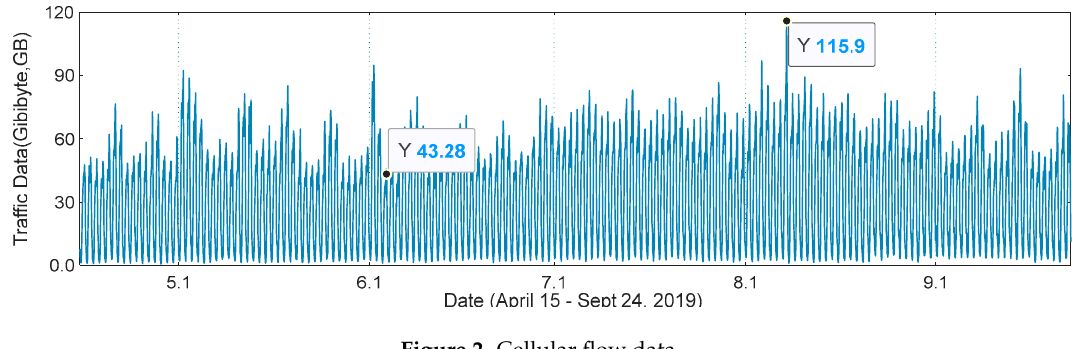
Figure 2. Cellular flow data.